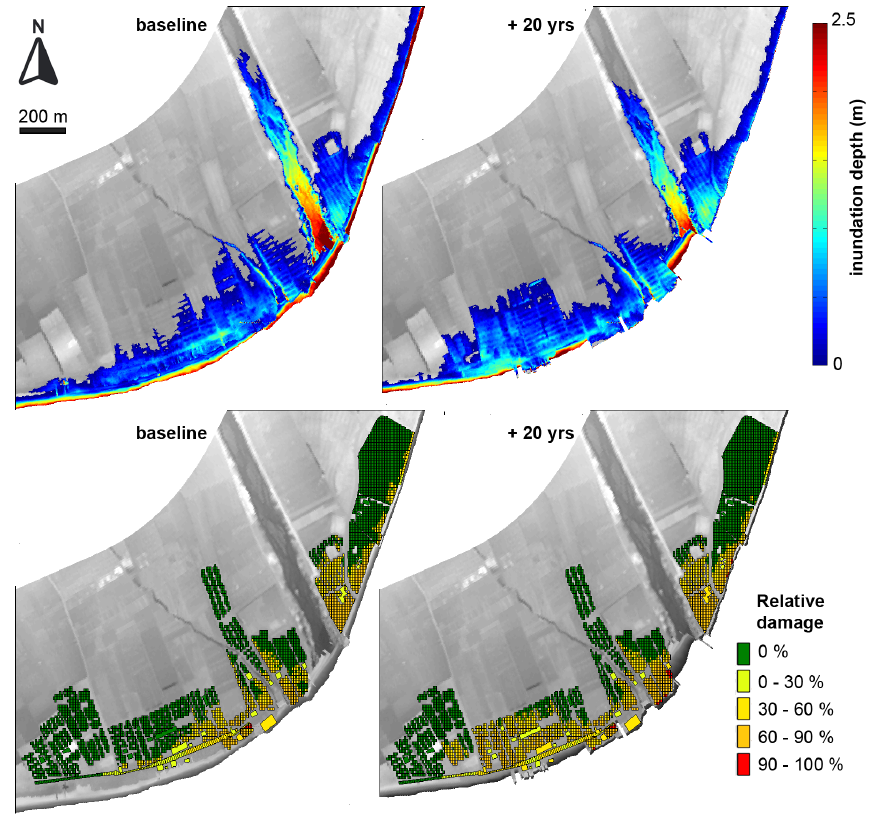
Figure 3. Example of transformation from inundation hazard to risk. Storm event of November 2001, Hs = 5.4m, Tp = 13s, eastern direction, and 96 h of event duration. Lidar provided by Institud Cartogràgic I Geològic de Catalunay (ICGC).